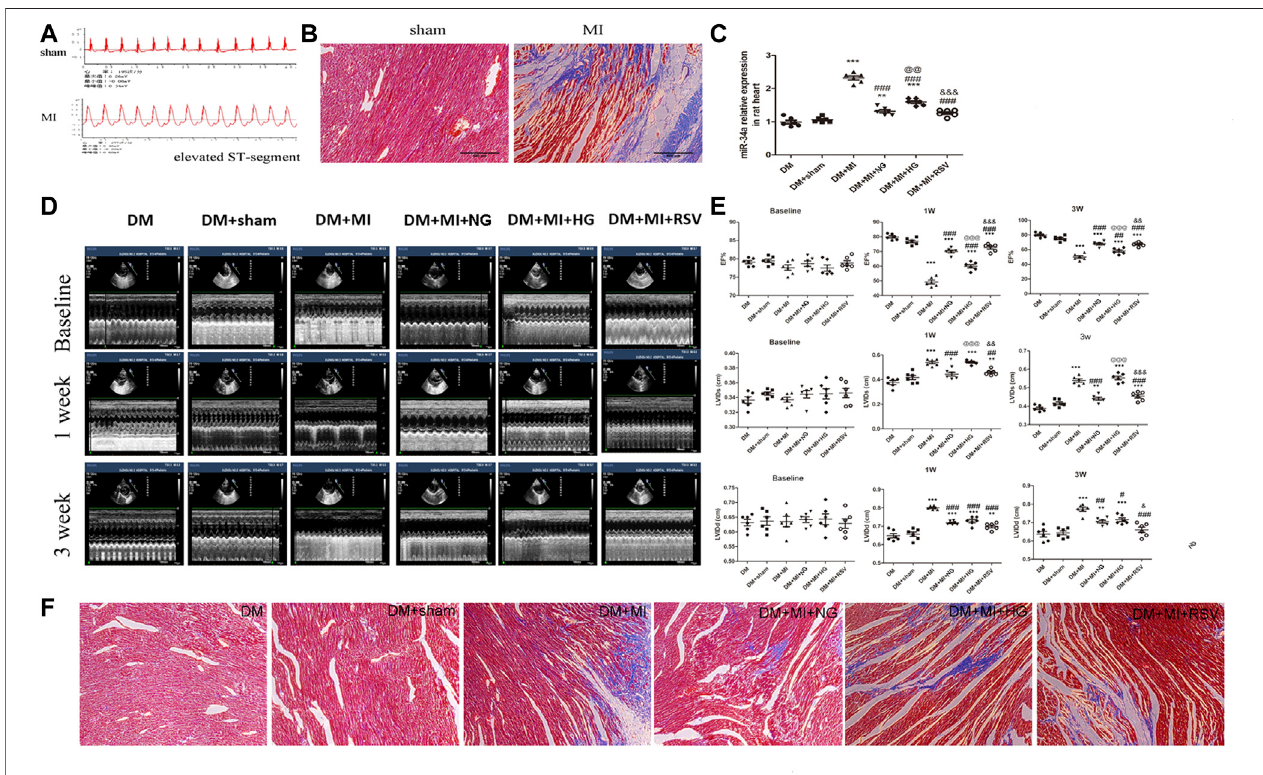
FIGURE 5 | RSV-BMSC transplantation improves cardiac function following infarction in diabetic rats (A,B) Electrocardiogram and Masson staining were used to detect the establishment of a rat model of diabetes with myocardial infarction. (C) qRT-PCR analysis was applied to detect the expression of miR-34a in each group. (D,E) Echocardiography showed the heart function in the control group and the experimental group at 1 and 3 weeks after operation. (F) Masson staining were used to detect in the control group and the experimental group at 3 weeks after operation. *** p ＜ 0.001 vs DM. ## p ＜ 0.01, ### p ＜ 0.001 vs DM + MI. @@ p ＜ 0.01, @@@ p ＜ 0.001 vs DM + MI + NG. && p ＜ 0.01, &&& p ＜ 0.001 vs DM + MI +